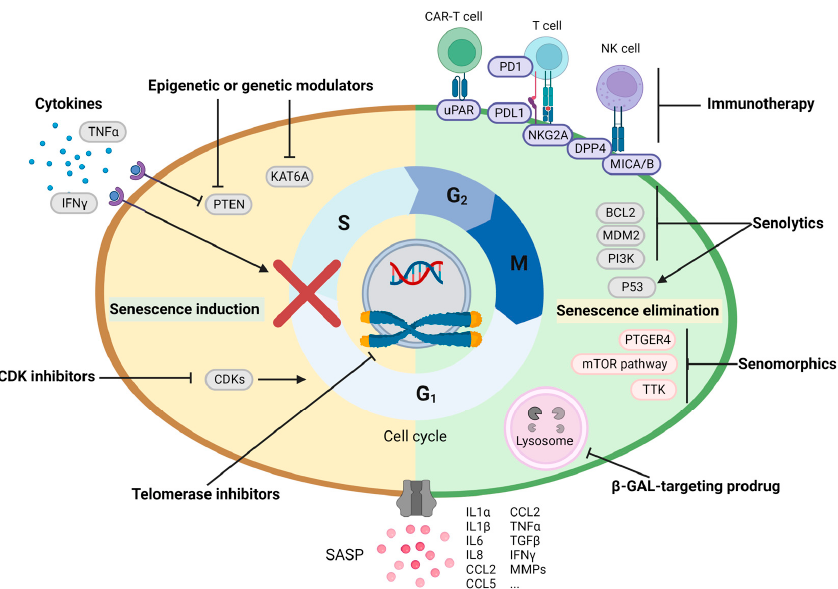
Figure 2. ‘Combo strikes’ targeting senescence as an anti-cancer strategy. Treating cancer with chemotherapy, irradiation or cell-cycle inhibitors to induce senescence (pro-apoptosis may be the major anti-cancer effect of chemotherapy and irradiation), which is accompanied by the immunosurveillance of these senescent cells. However, some senescent cells escape from being eliminated by the immune cells (NK cells, macrophages and cytotoxic T cells). The surviving senescent cells may cause chronic inflammation, thereby creating an immunosuppressive microenvironment to allow cancer relapse or self-reprogramming to gain stemness signature and senescence escape. To further prevent disease relapse, these detrimental senescent cells can be removed by the pro-apoptosis or anti-survival senolytics, β -galactosidase-targeting prodrugs, SASP-regulating senomorphics, as well as antibody-based and immune cells-based immunotherapy.